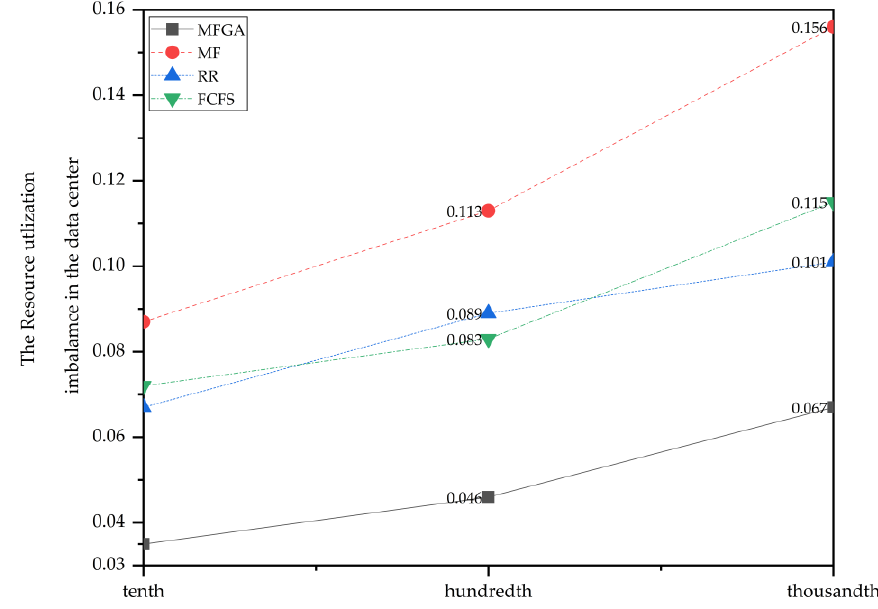
Figure 11. Comparison of resource utilization imbalance compared with four algorithms.